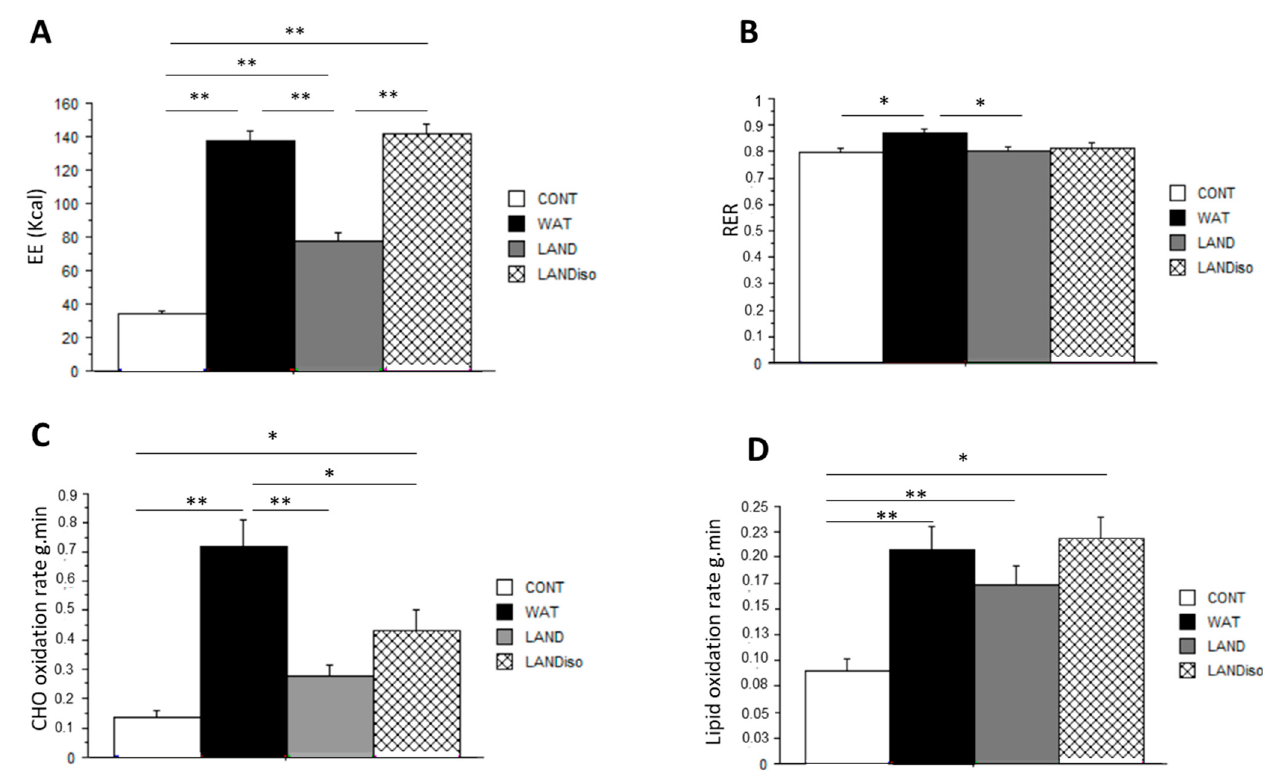
Figure 2. Energy expenditure and substrate utilization rates. ( A ) Energy expenditure (EE); ( B ) respiratory exchange ratio (RER), ( C ) carbohydrate oxidation rates and ( D ) lipid oxidation rates are presented for control (CONT), water-cycling (WAT), land-cycling (LAND) and land isoenergetic cycling (LAND-Iso) session. Data presented as mean ± SD; post hoc pairwise comparisons using Scheffe test were performed. *, **: significantly different at p < 0.05 and p < 0.01, respectively.